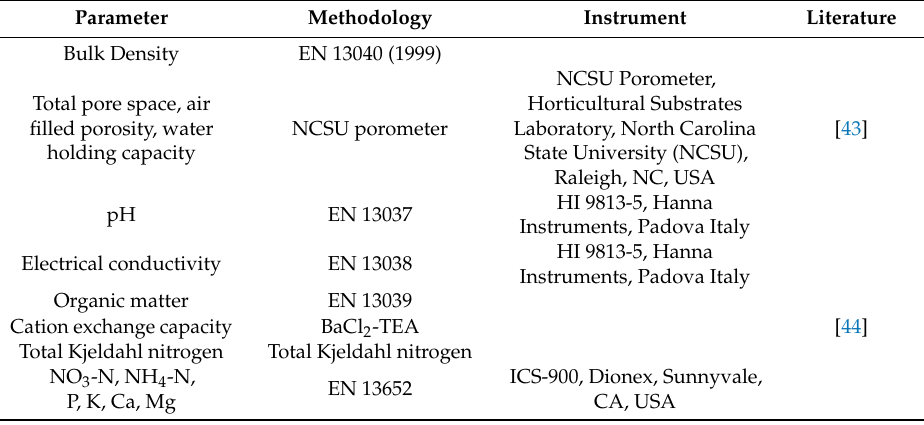
Table 2. Physical and chemical characteristics determined in the evaluated substrates.